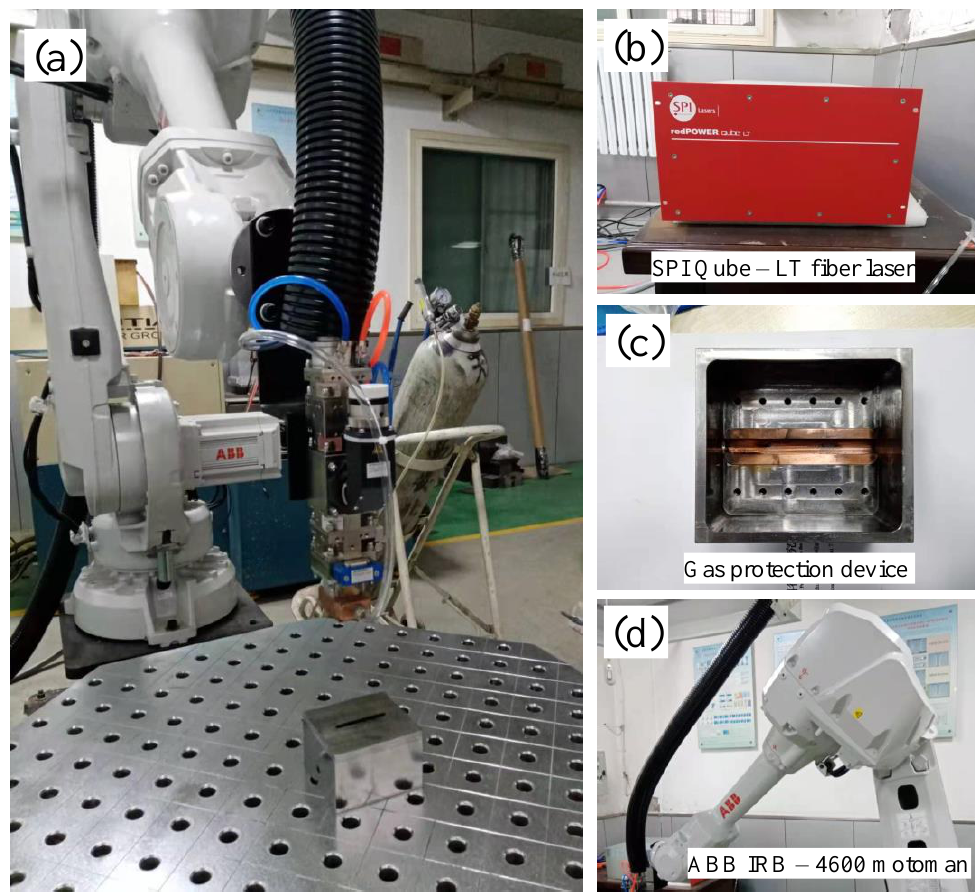
Figure 2. ( a ) The single-mode fiber laser welding system; ( b ) SPI fiber laser; ( c ) gas protection device; ( d ) ABB motorman.